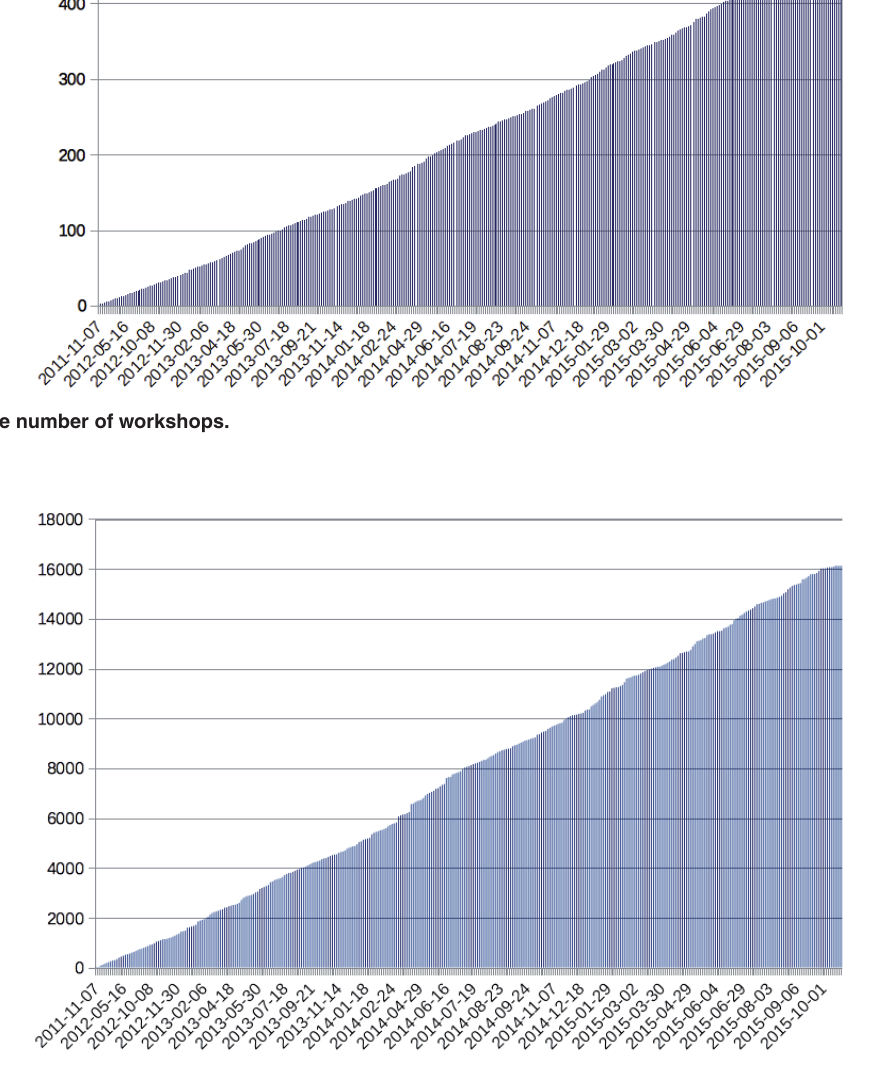
Figure 2. Cumulative number of learners.